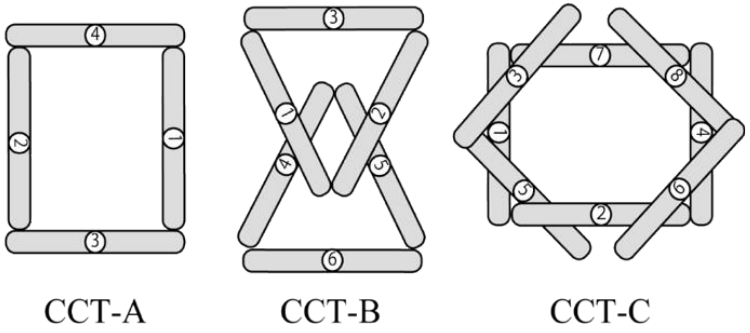
Figure 2. Three composition tests in CCT.